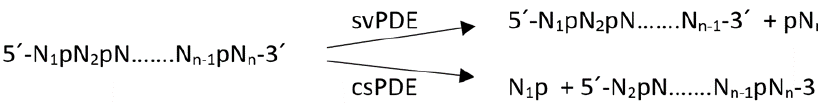
Scheme 1. Products of the cleavage of DNA/RNA oligonucleotides catalyzed by 3´ → 5´-exonuclease